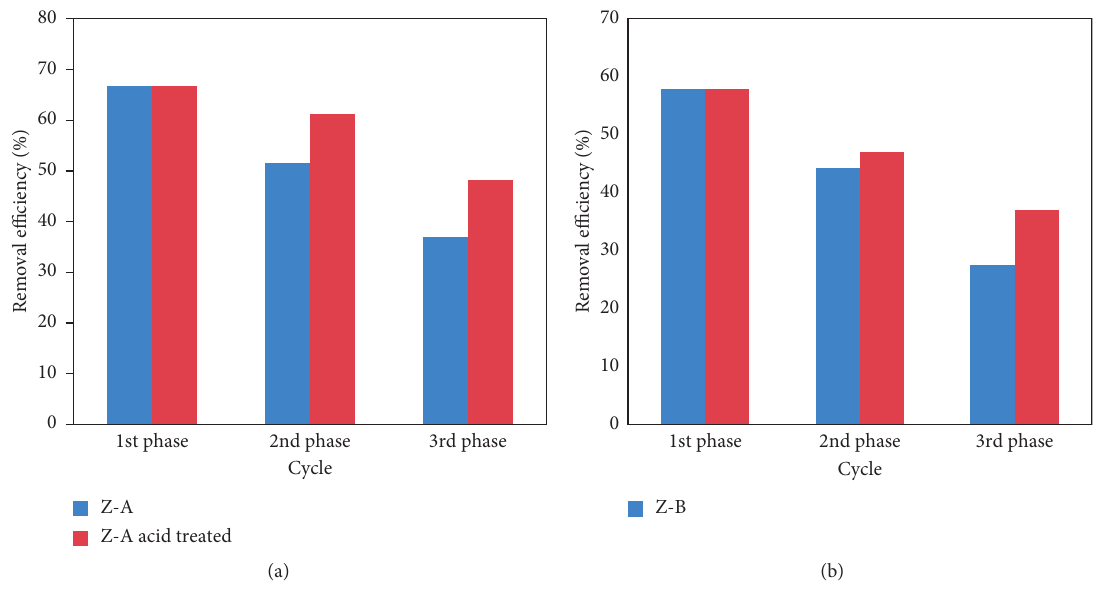
Figure 8: (a) The recyclability of Z-A and (b) the recyclability of